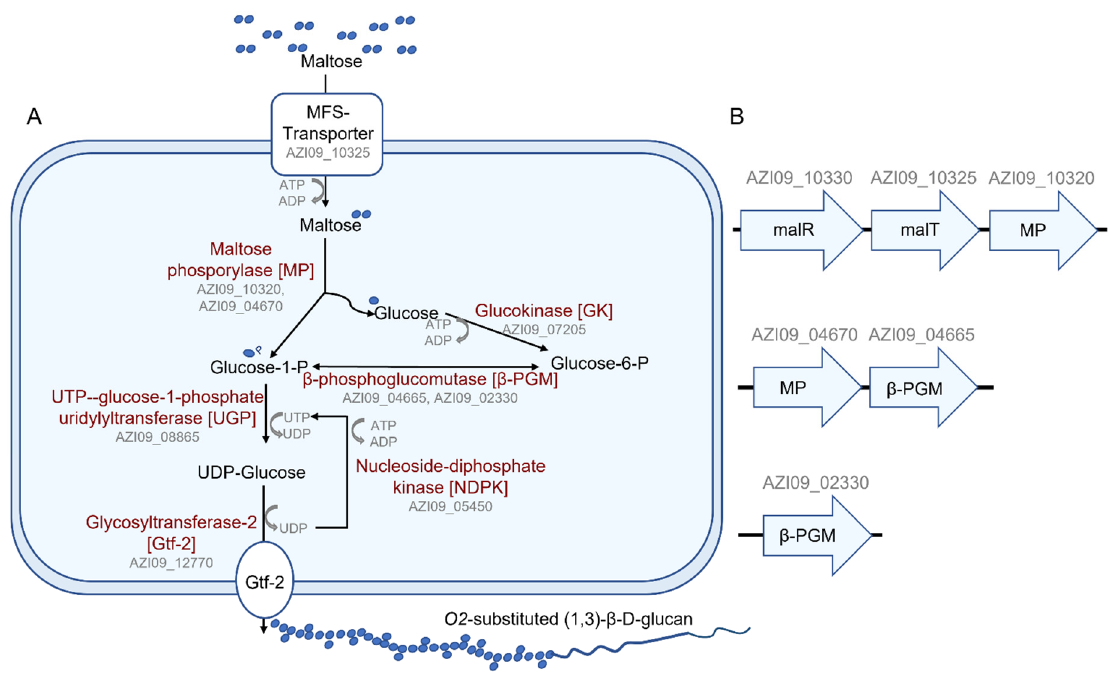
Figure 8. β -glucan biosynthesis of L. brevis TMW 1.2112. ( A ) Metabolic pathway of the β -glucan biosynthesis, as suggested from genomic data and proteomic analysis. ( B ) Suggested maltose operons: malR = transcriptional regulator, MP = maltose phosphorylase, malT = MFS maltose transporter and β -PGM = β -phosphoglucomutase.